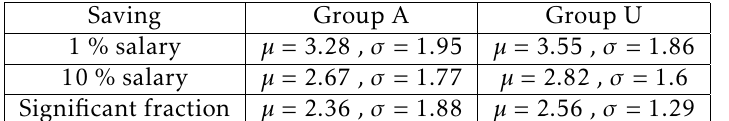
Table 2. Relationship between participants’ awareness status and responses to the Brand Trust questions